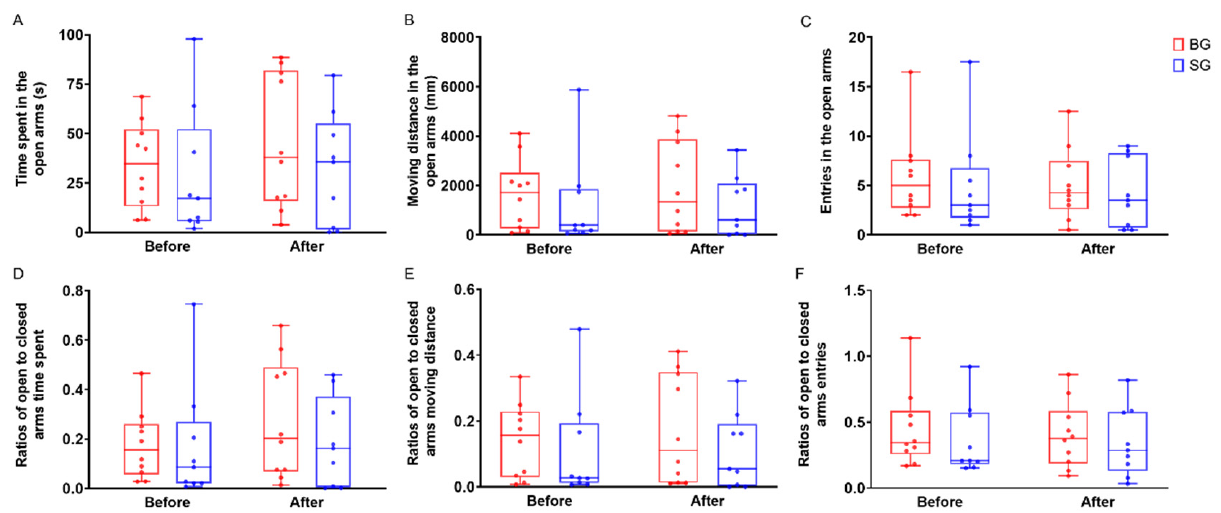
Figure 4. Boldness behavior variables change in Mongolian gerbils before and after fecal microbiota transplantation. ( A ) time spent in the open arms; ( B ) moving distance in the open arms; ( C ) entries in the open arms; ( D ) ratios of open to closed arms entries; ( E ) ratios of open to closed arms time spent; ( F ) ratios of open to closed arms moving distance. Data are means ± SEM. (BG: “bold fecal” gavage group, SG: “fecal” gavage group).